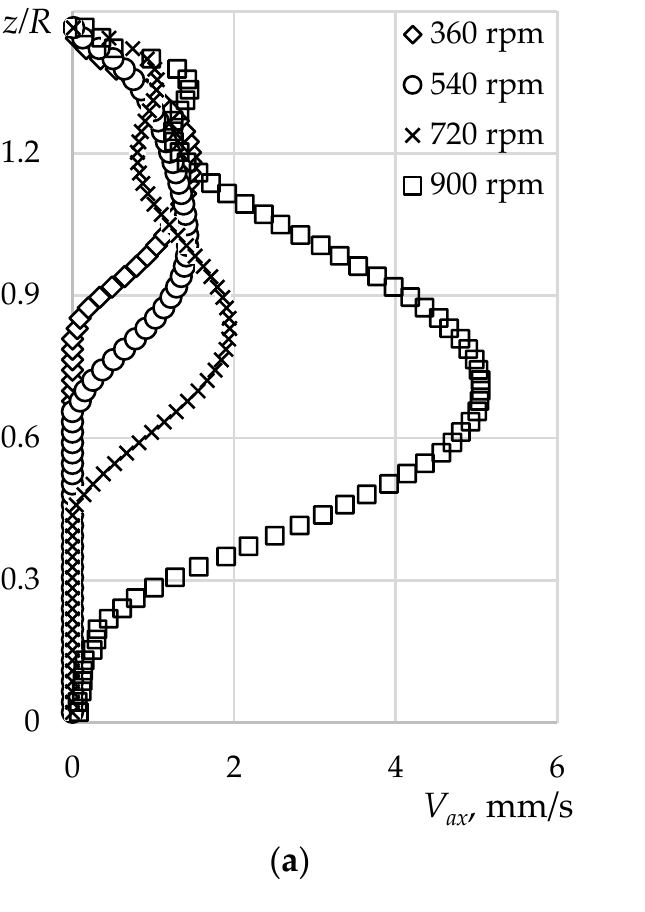
Figure 9. The profiles of the axial velocity component at ( a ) h = 0.5 and ( b ) 0.8.